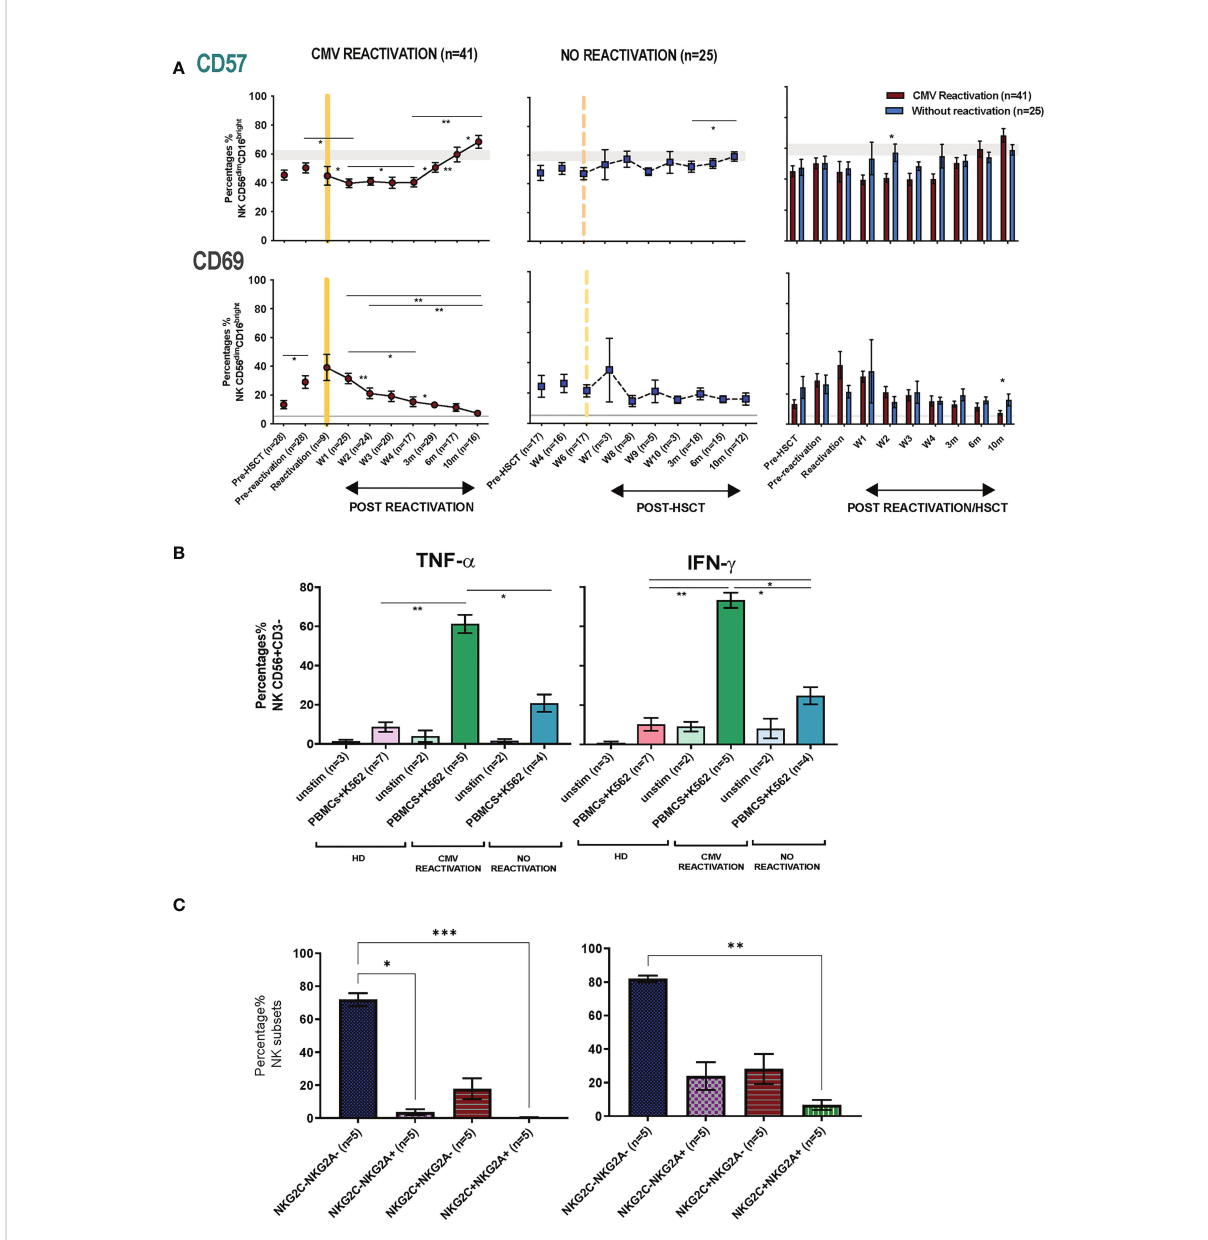
FIGURE 5 NK cells from HSCT patients who have undergone an episode of CMV reactivation demonstrate early proliferation with subsequent maturation and enhanced production of cytokines. (A) The percentage of CD57+ and CD69+ on NK cells from patients following CMV reactivation (purple line and bar) or without CMV reactivation (blue line and bar). Grey lines represent the range of CD57+ and CD69+ NK cells in healthy controls. (*p<0.05, **p<0.01, ***P<0.001; Wilcoxon sign rank test for matched phenotypes). (B) Enhanced TNF- a (left panel) and IFN- g (right panel) production from NK cells of HSCT patients following prior CMV reactivation. Data are shown as percentage of cytokine-positive NK cells following K562 stimulation. (*p<0.05**p<0.01; Anova test). (C) TNF- a (left panel) and IFN- g (right panel) production from four NK